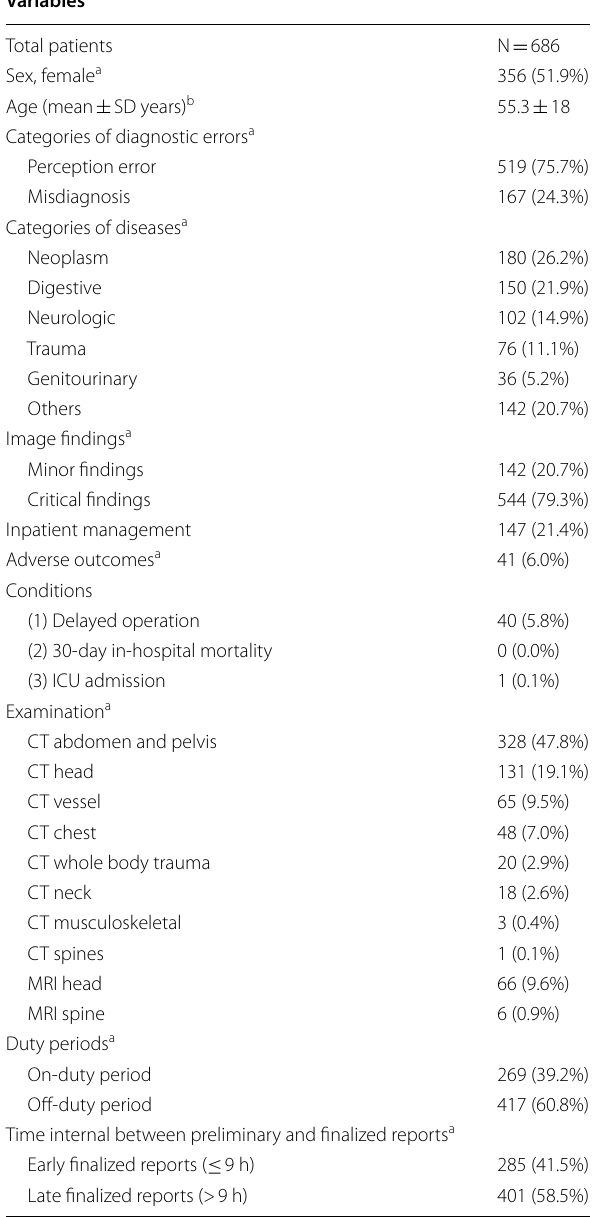
Table 1 Baseline characteristics of study